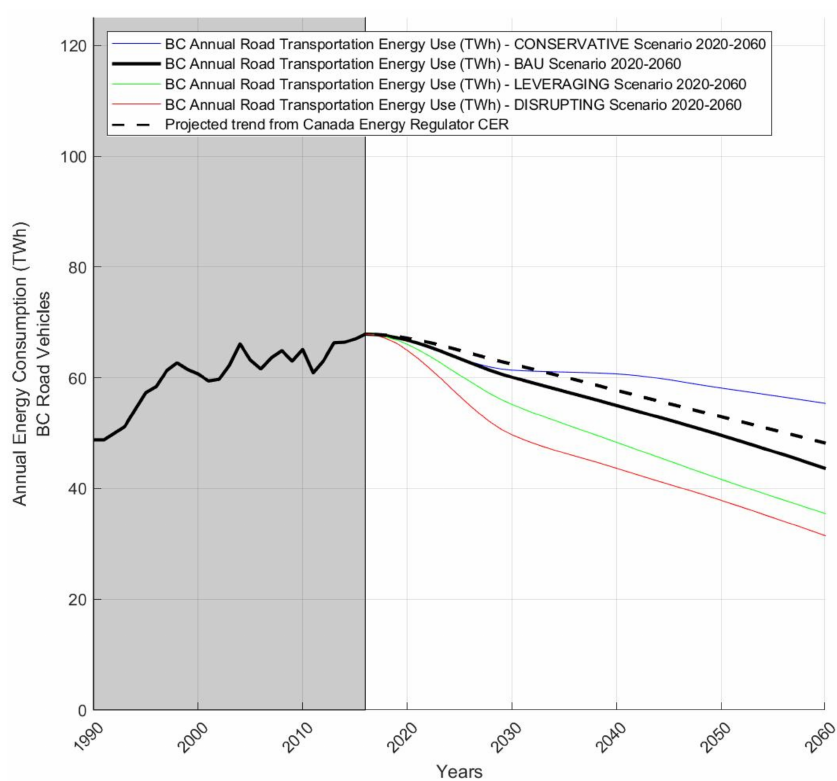
Figure 11. B.C. road transportation annual energy use in (TWh), impacts of vehicle electrification, travel demand increases due to vehicle automation, more energy use of automated vehicles arising from fueling, charging, and deadheading, less energy use of automated vehicles arising from less congestion, fleet operations, platooning, and parking easiness.